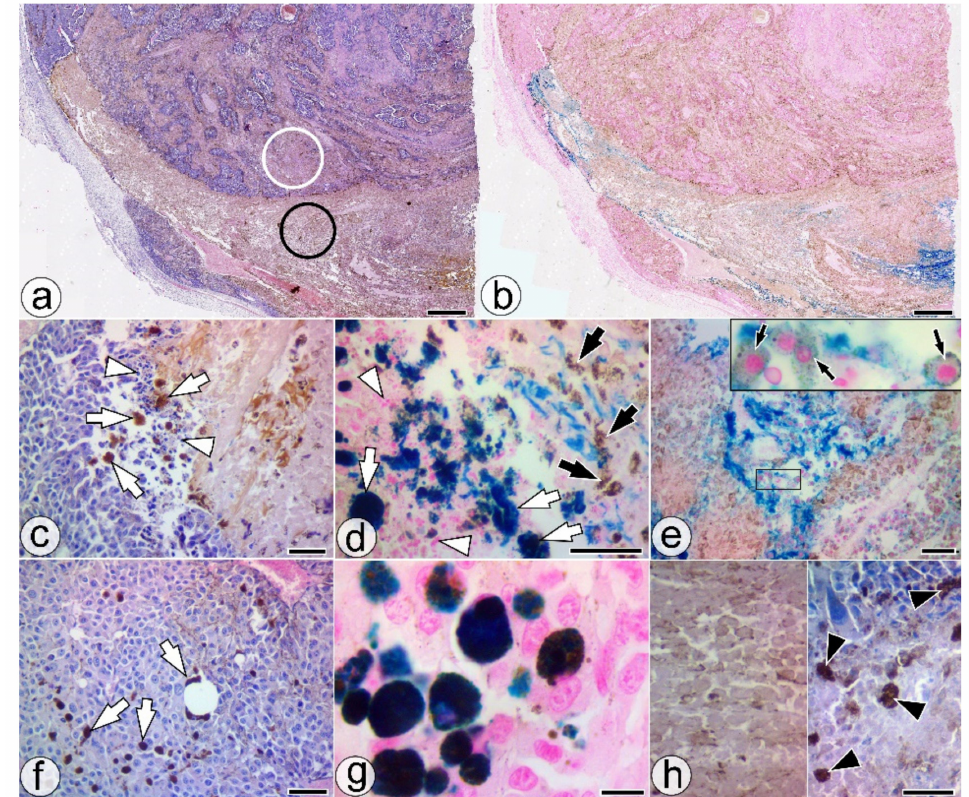
Figure 3. Histological features of the SaIONs injected area in the ITM1w group. ( a , b ) Overall appearance of SaIONs-induced necrosis (black circle) in the injected area, with a different morphology from the adjacent programmed necrosis (white circle). ( c , d ) The border between the growing tumor and the nanoparticle-induced tumor necrosis with apoptotic bodies (white arrowheads), large MAC387- NP-PCs (white arrows), and melanin-loaded ghost cells without nuclei (black arrows). ( e ) SaIONs-induced tumor necrosis area with nests of viable PMCs (black arrows) surrounded by SaIONs deposits. ( f , g ) Melanoma tissue with large migratory NP-PCs (white arrows). ( h ) Higher magnification of the SaIONs-induced necrosis area (left) with pigmented ghost cells without nuclei, and the programmed necrosis area (right) with fragmented nuclei and numerous melanophages (black arrowheads). HE ( a , c , f , h ) and Perls’ Prussian blue staining ( b , d , e , g ). Bar = 10 µ m ( g ), 20 µ m ( d , h ), 50 µ m ( c , e , f ), 1 mm ( a , b